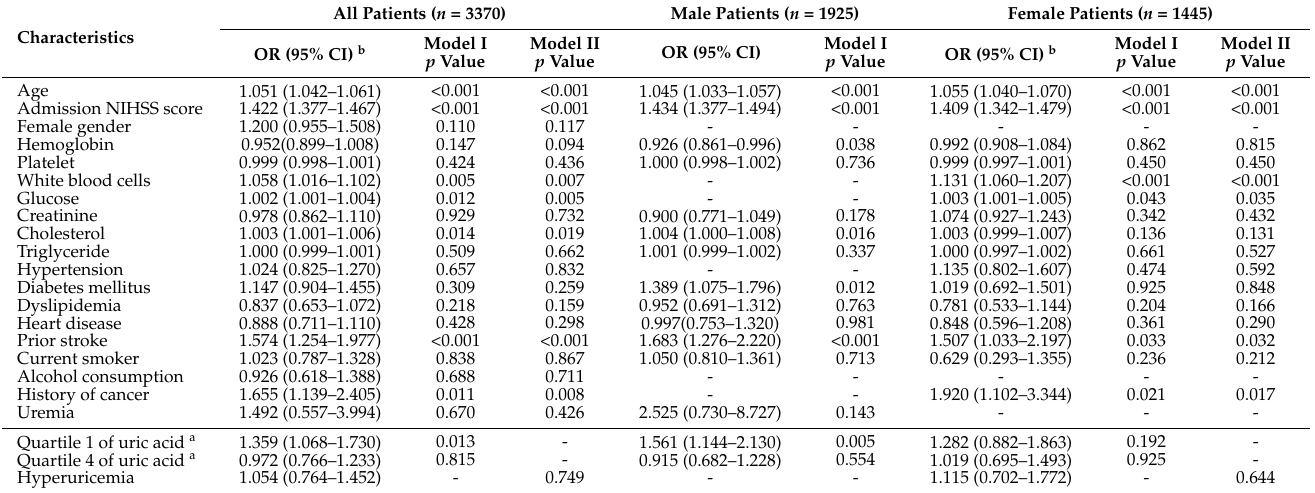
Table 7. Multivariable analysis of factors influencing unfavorable outcomes (modified Rankin Scale score > 2) in 3370 patients with acute ischemic